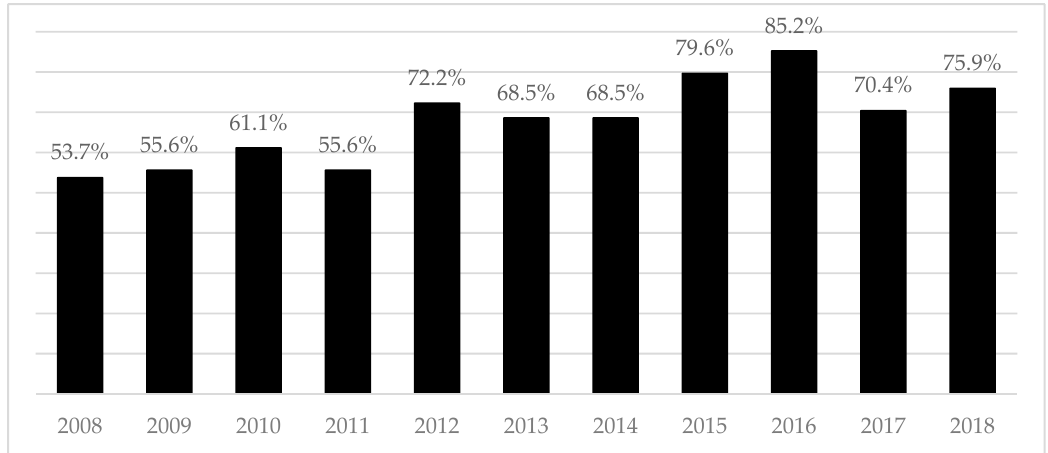
Figure 4. Share of distribution utilities that failed to reach their regulatory PNTLs over the period of 2008–2018 [9].